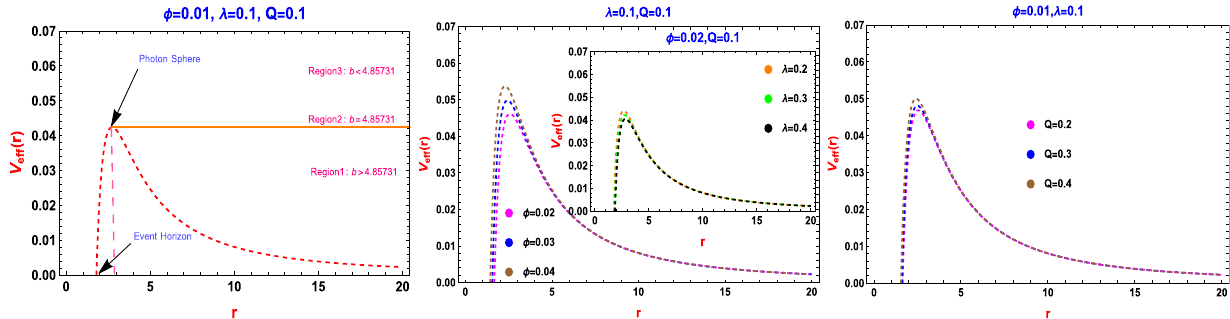
Fig. 1 The effective potential of the considered BH for some fixed values of state parameters (left panel), for different φ and λ (middle panel) and for different Q (right panel) with M = 1